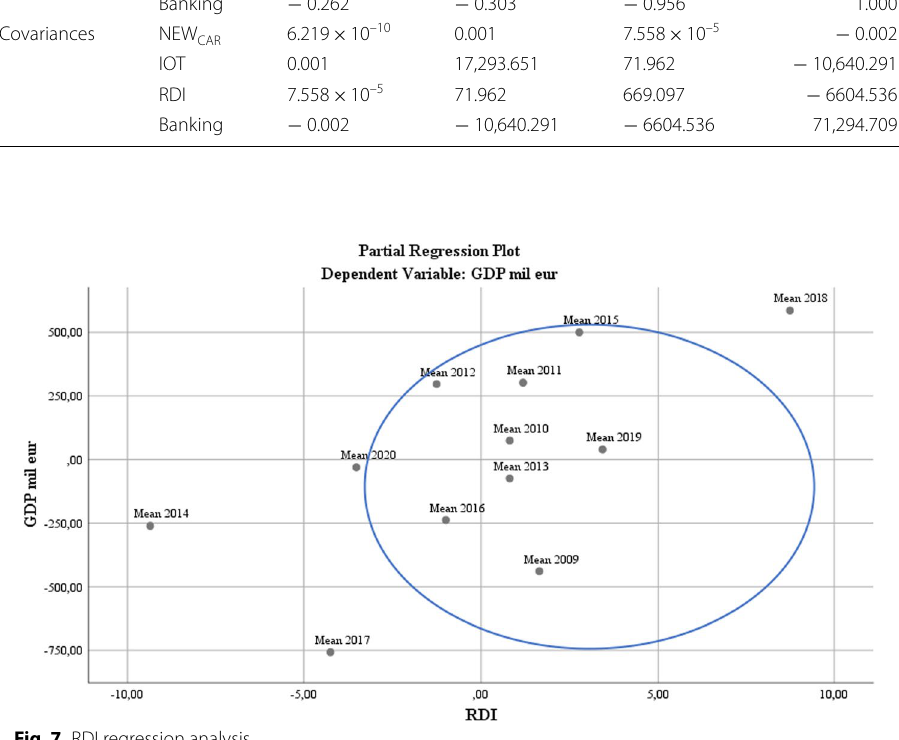
Fig. 7 RDI regression